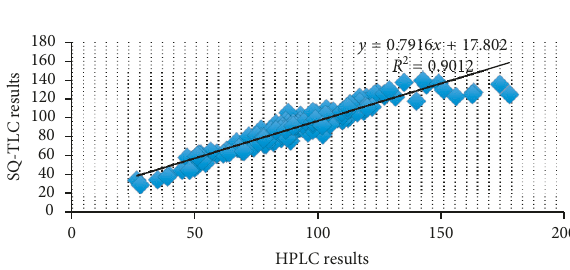
Figure 2: Correlation between HPLC and SQ-TLC results for API components of antimalarial